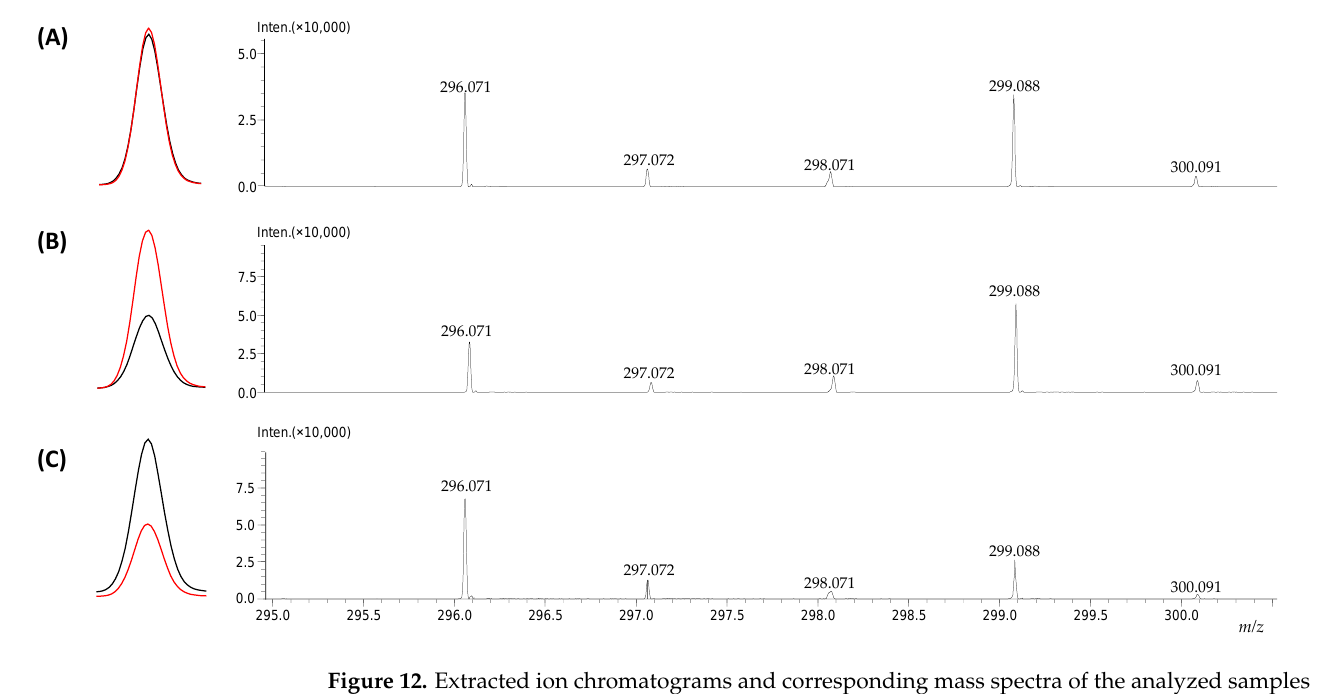
Figure 12. Extracted ion chromatograms and corresponding mass spectra of the analyzed samples containing armodafinil (black line) and armodafinil-d 3 (pink line) mixed in ( A ) 1:1 ratio ( B ) 1:2 ratio, ( C ) 2:1 ratio.